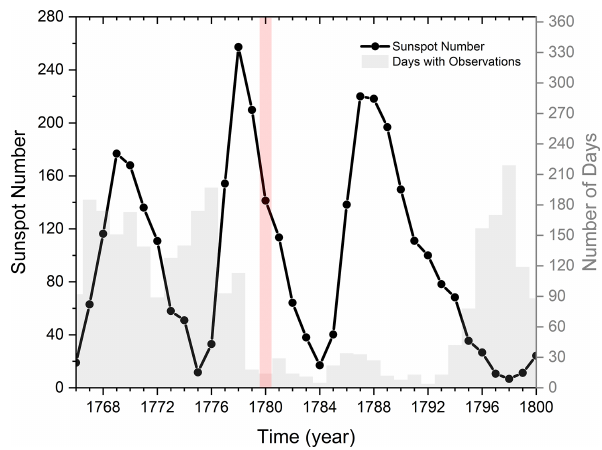
Figure 3. Annual total sunspot numbers and number of days with solar observations (SILSO, 2020, WDC sunspot number).